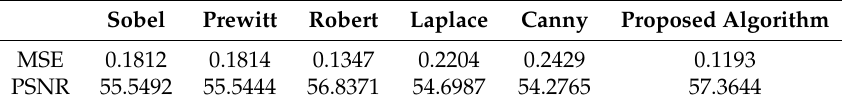
Table 1. Comparison of mean square error (MSE) and peak signal-to-noise ratio (PSNR) between the proposed algorithm and other conventional